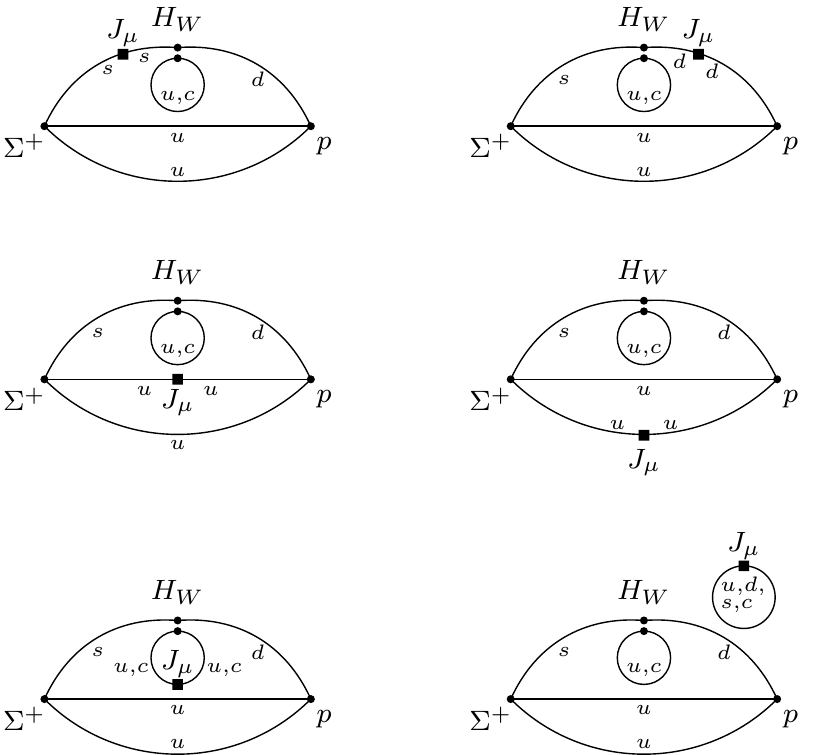
Figure 6 . Four-point diagrams for the E class. The squared vertex shows the insertion of the electromagnetic current J µ